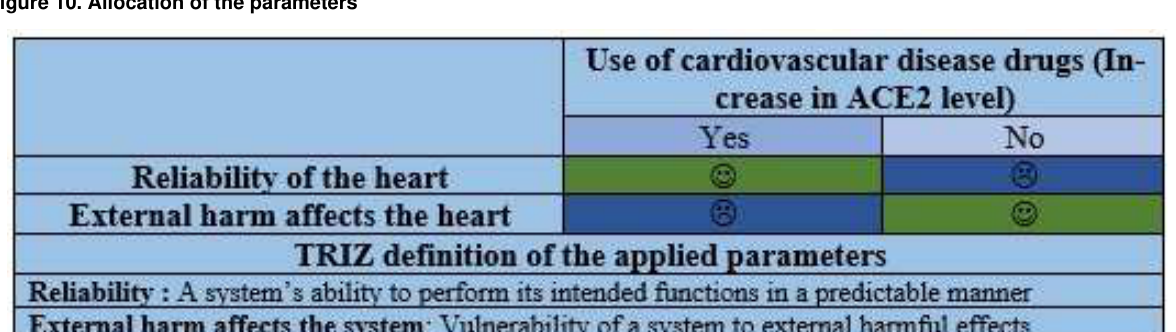
Figure 10. Allocation of the parameters